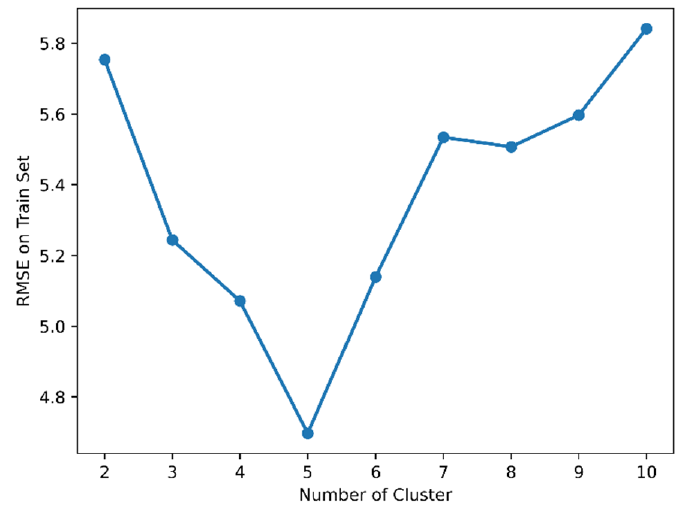
Figure 4. The performance of BiLSTM on the training set. When the number of K clusters increased, the training error of BiLSTM first decreased and then increased. When there were five K clusters, the training set RMSE value was the smallest (4.70). Therefore, the IMF components were combined and reorganized into five reconstruction sequences Feat i ( I = 1, 2, · · · , 5). To reflect the changes more intuitively in the reconstruction sequence, the results of the partial component reconstruction are shown in Figure 5.